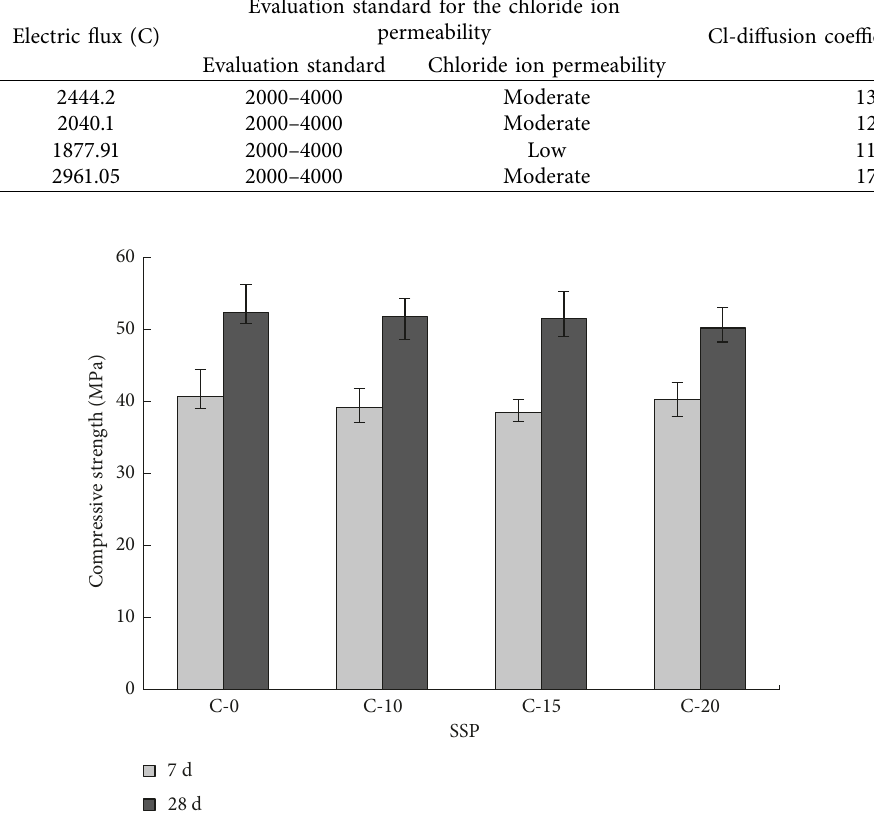
Figure 14: Carbonation depth of concrete.